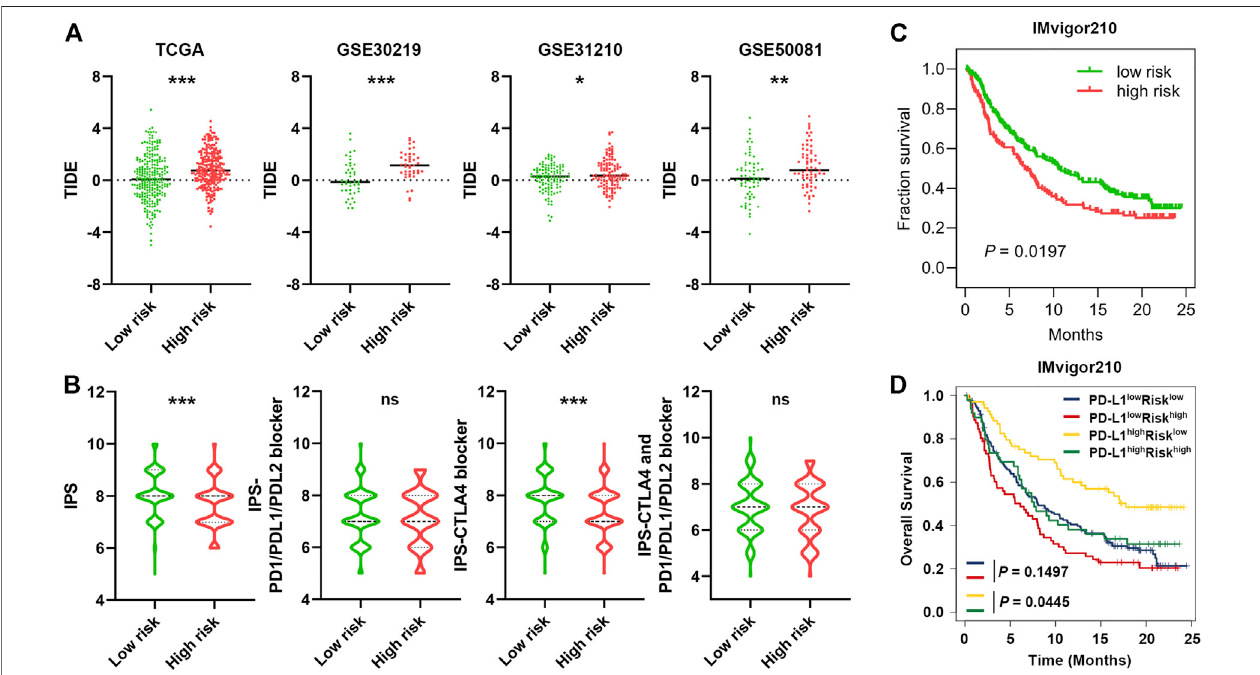
FIGURE 7 | Predictive potential of SRS in immunotherapeutic bene fi ts. (A) . The distribution of TIDE scores between patients with a higher SRS score and those with a lower SRS score in four different cohorts as indicated. (B) . The distribution of IPS in the high-risk and low-risk groups in the TCGA dataset. (C) . Kaplan-Meier curves for high and low SRS score patient groups in the IMvigor210 cohort. (D) . Kaplan-Meier curves for four patient groups strati fi ed by SRS and PD-L1 expression. *, **, and *** represent P < 0.05, P < 0.01, and P < 0.001, respectively.